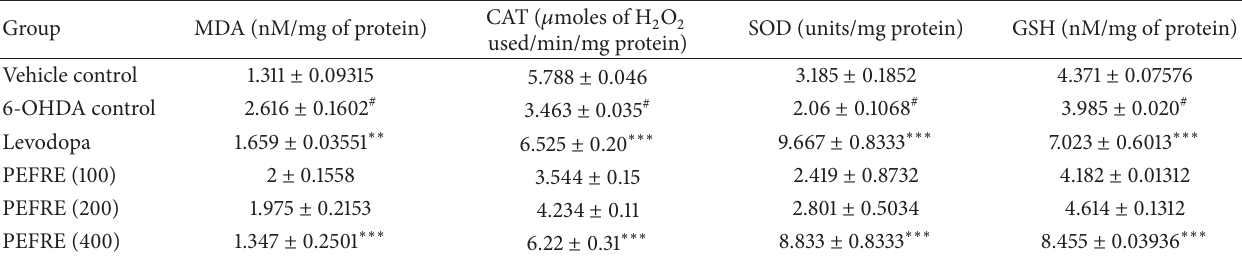
Table 2: Effect of PEFRE on the levels of lipid peroxidation (MDA), catalase (CAT), superoxide dismutase (SOD), and reduced glutathione (GSH) in the brain of 6-OHDA treated animals.